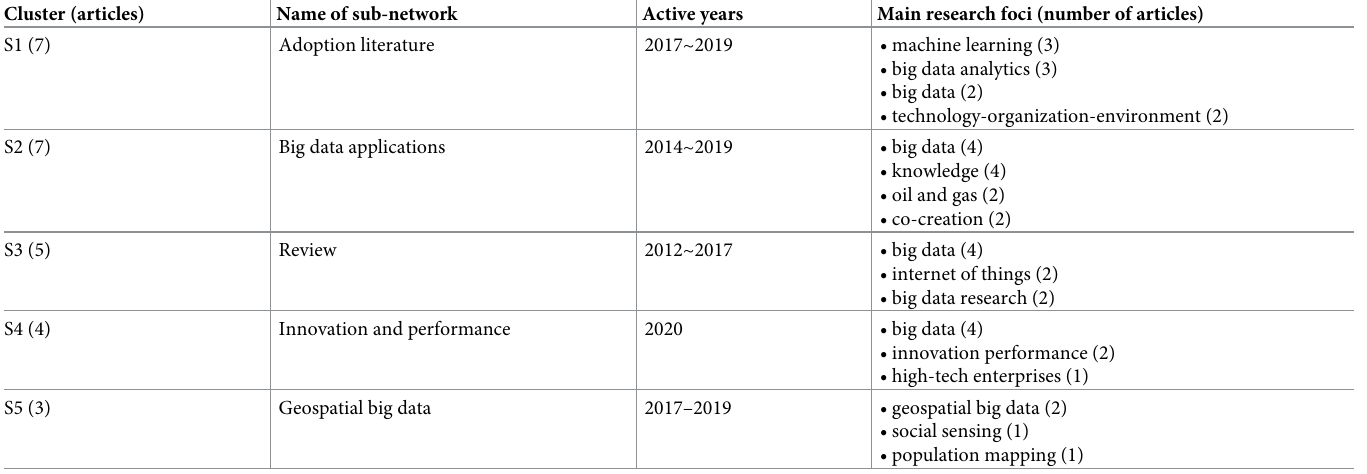
Table 5. Summary of research foci in Global South